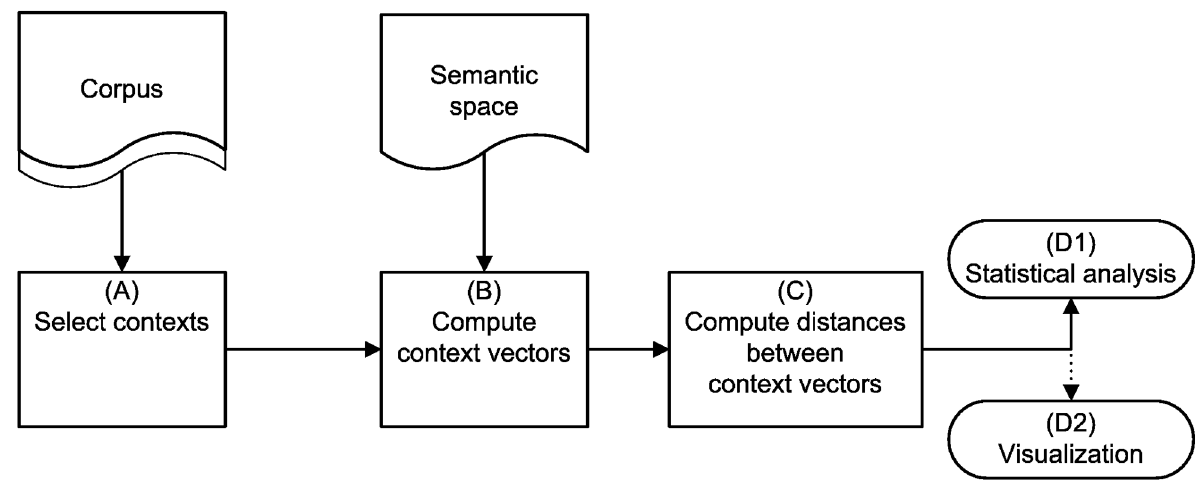
Figure 2. A schematic diagram of the method presented in this paper. The method we present in this paper is comprised of 4 distinct steps. (A) In the first step an appropriate set of contexts is selected from a corpus based on keywords that represent the target word and its possible frames. (B) Next, a vector is computed for each context using vector addition. The vectors for each word are provided by a pre-computed semantic space. (C) In the third step, distances are computed between related groups of context vectors (i.e., the target word and its possible frames). (D) Finally, a statistical analysis (D1) and an optional visualization (D2) are performed on the resulting